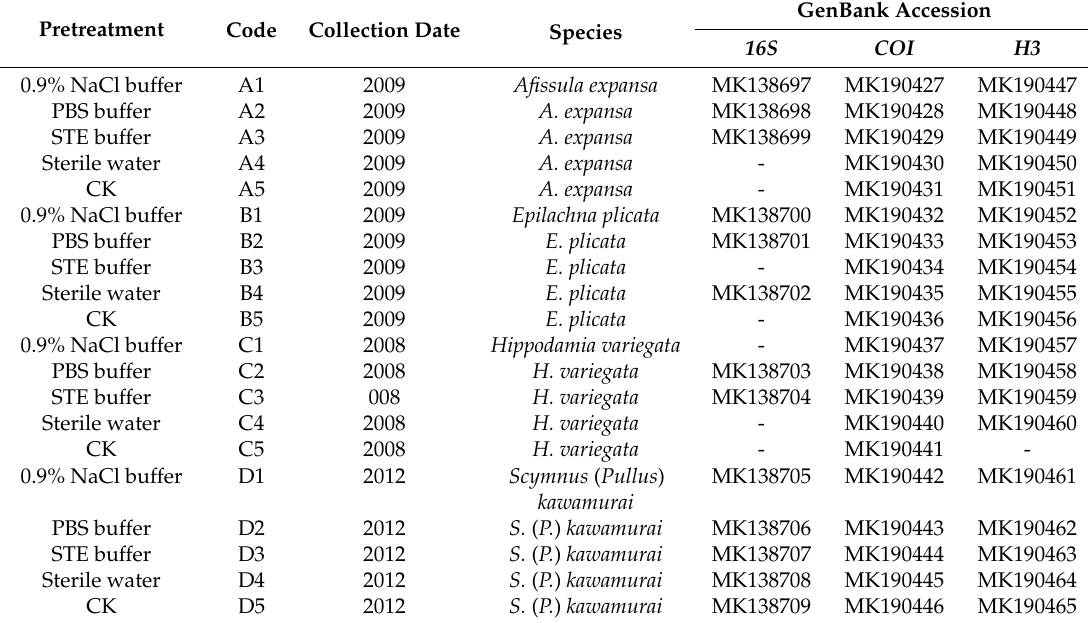
Table 1. Information on sample pretreatments, collection date, species and code information of museum specimen of five different coccinellid species used in the experiment.